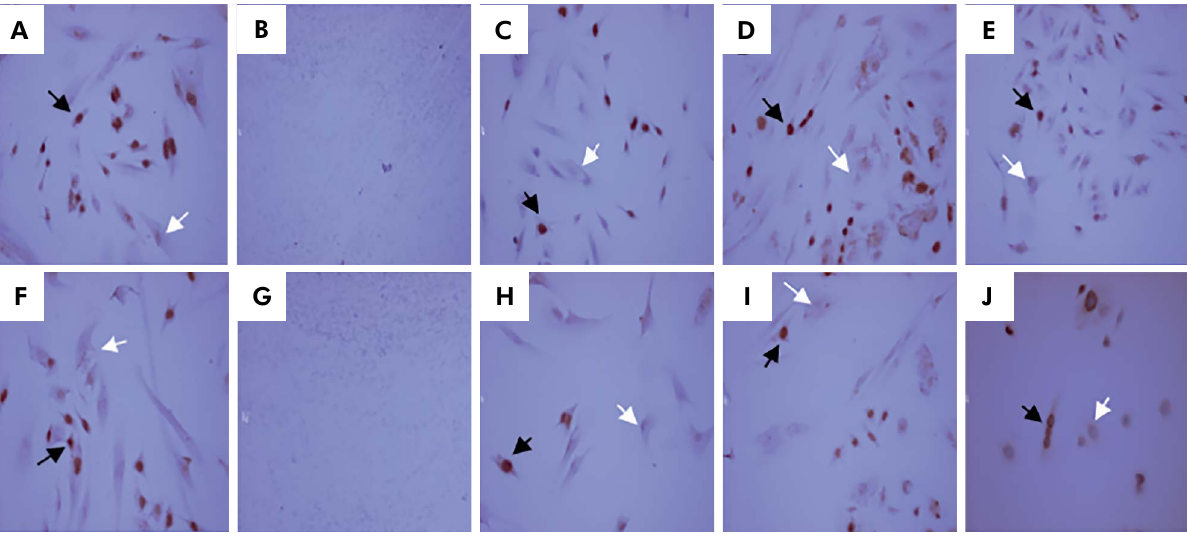
Figure 1. BrdU assay of HGF cells showed proliferative cells represented by labeled brown nucleus (black arrow) and no labeled nucleus (white arrow). Positive control group (DMEM) at 1h (A); Negative control group (tap water) at 1h (B); ScLL 10 µg/ml at 1h (C); ScLL 5 µg/ml at 1h (D); ScLL 2 µg/ml at 1h (E); DMEM at 5h (F); Tap water at 5h (G); ScLL 10 µg/ml at 5h (H); ScLL 5 µg/ml at 5h (I); ScLL 2 µg/ml at 5h (J). 10× magnification. Bars scale 10